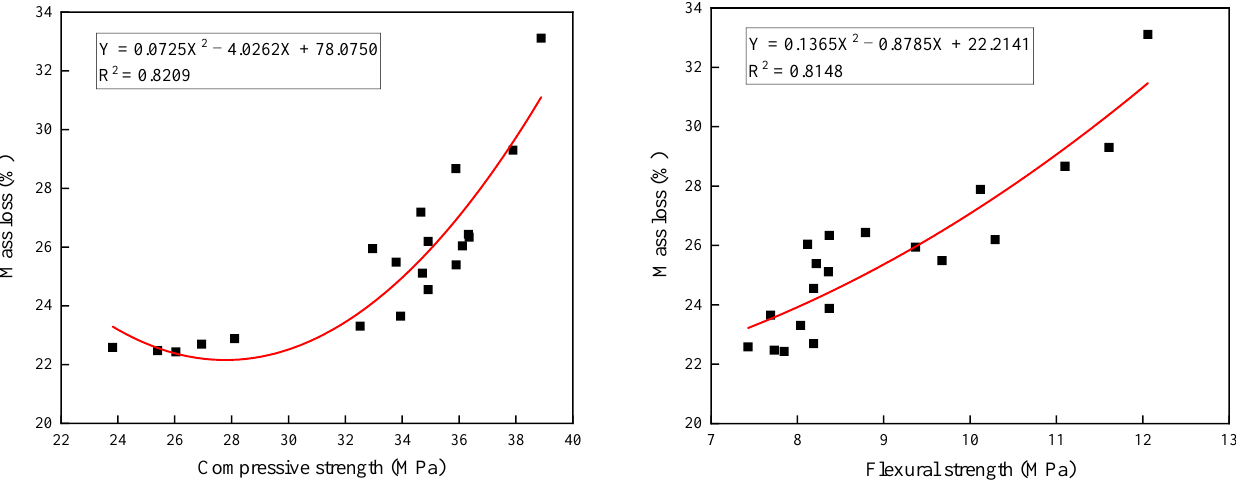
Figure 12. The relationship between strength and mass loss.